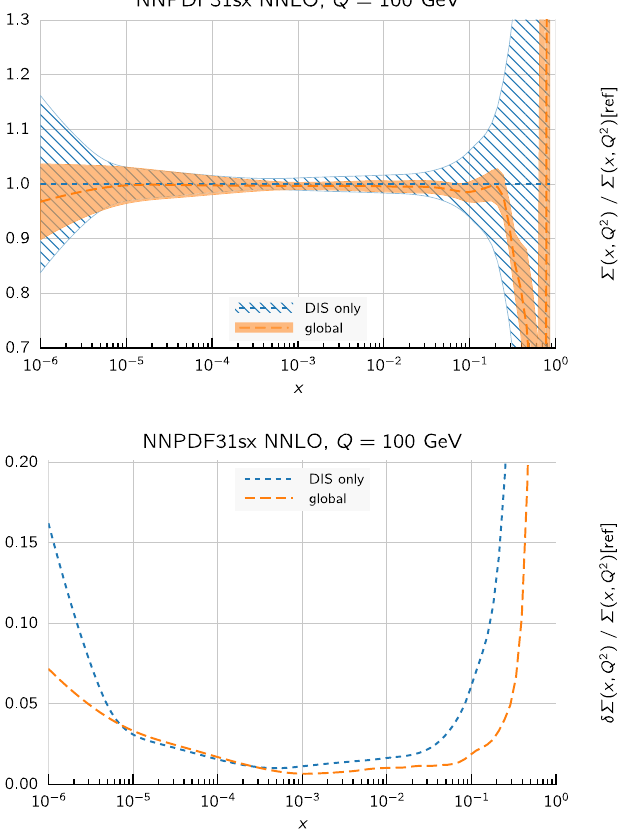
the DIS-only fit results, while the bottom plots compare the relative PDF uncertainty between the two